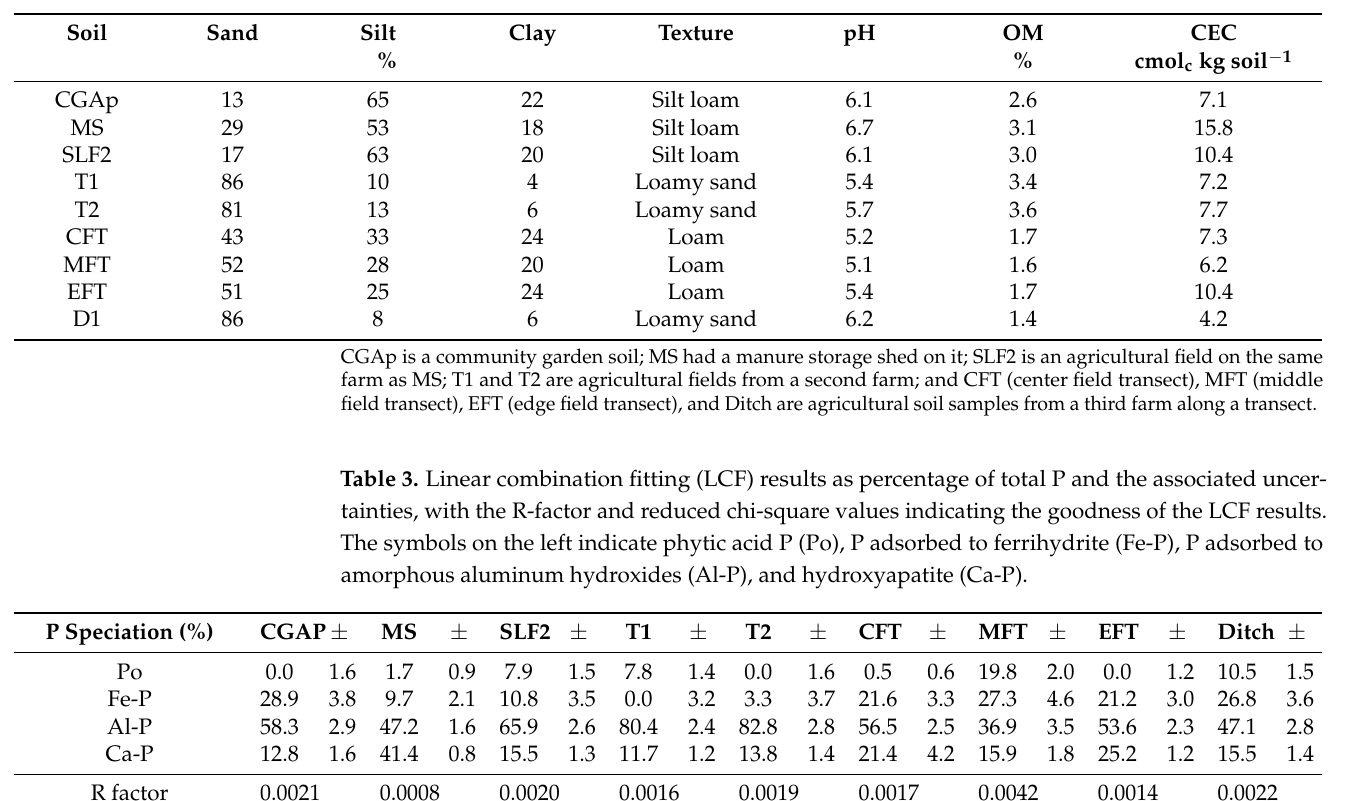
Table 2. Soil texture, soil pH, organic matter (OM), and cation exchange capacity (CEC) of composite agricultural soil samples collected throughout the Delmarva Peninsula.